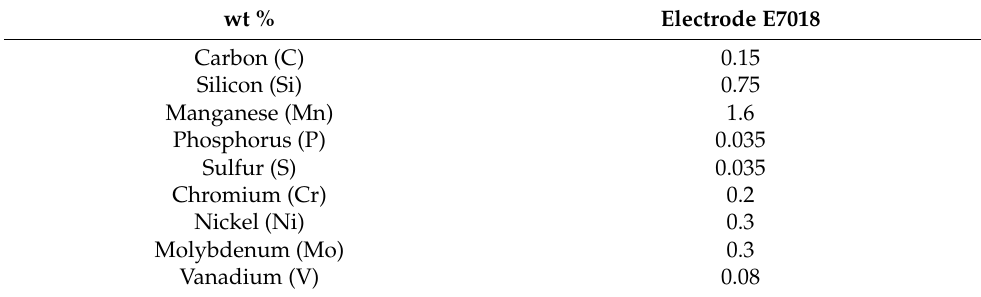
Table 2. Chemical composition (wt %) of the E7018 electrode [20].